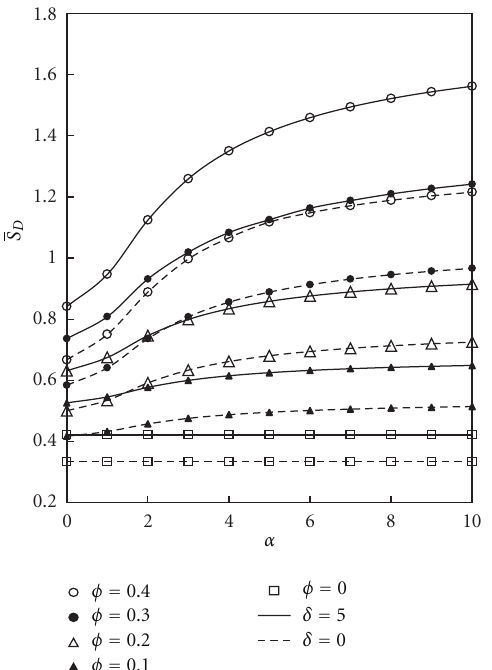
Figure 3: Variation of dynamic damping coe ffi cient with respect to volume concentration parameter φ for film thickness ratio r = 2 and di ff erent values of α .